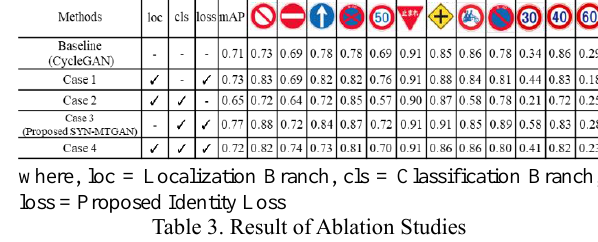
Table 3. Result of Ablation